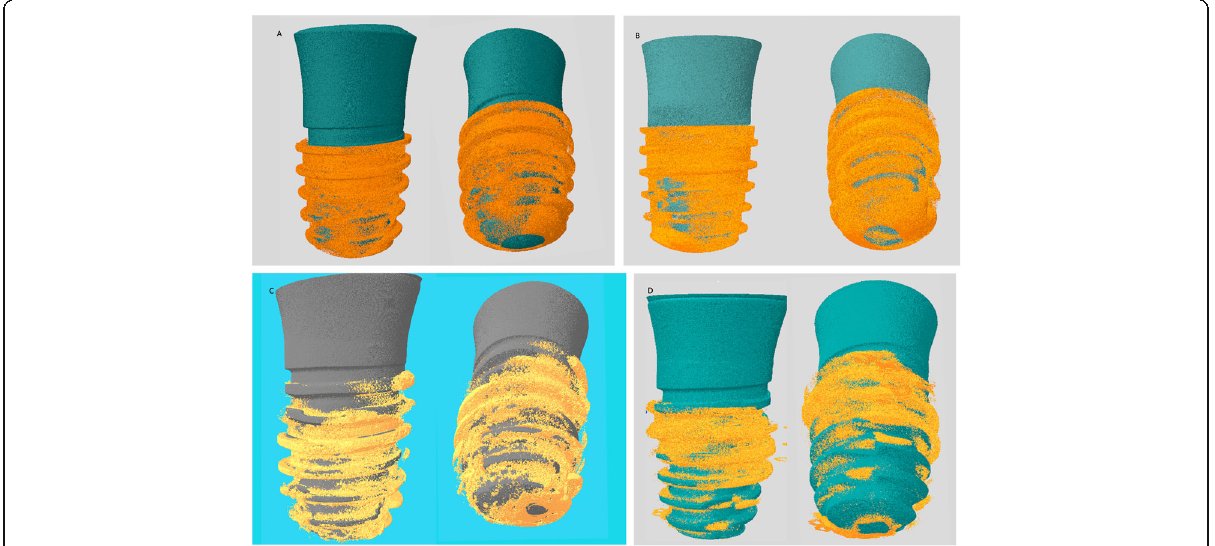
Fig. 3 3D images of the new bone formation at peri-implant area in the groups obtained from micro-CT analysis. Note that the increase in the bone volume of the osteoporotic bone around the implant treated with LLLT in OVX-LLLT compared with OVX. a ShamOVX-LLLT, b ShamOVX, c OVX-LLLT, d